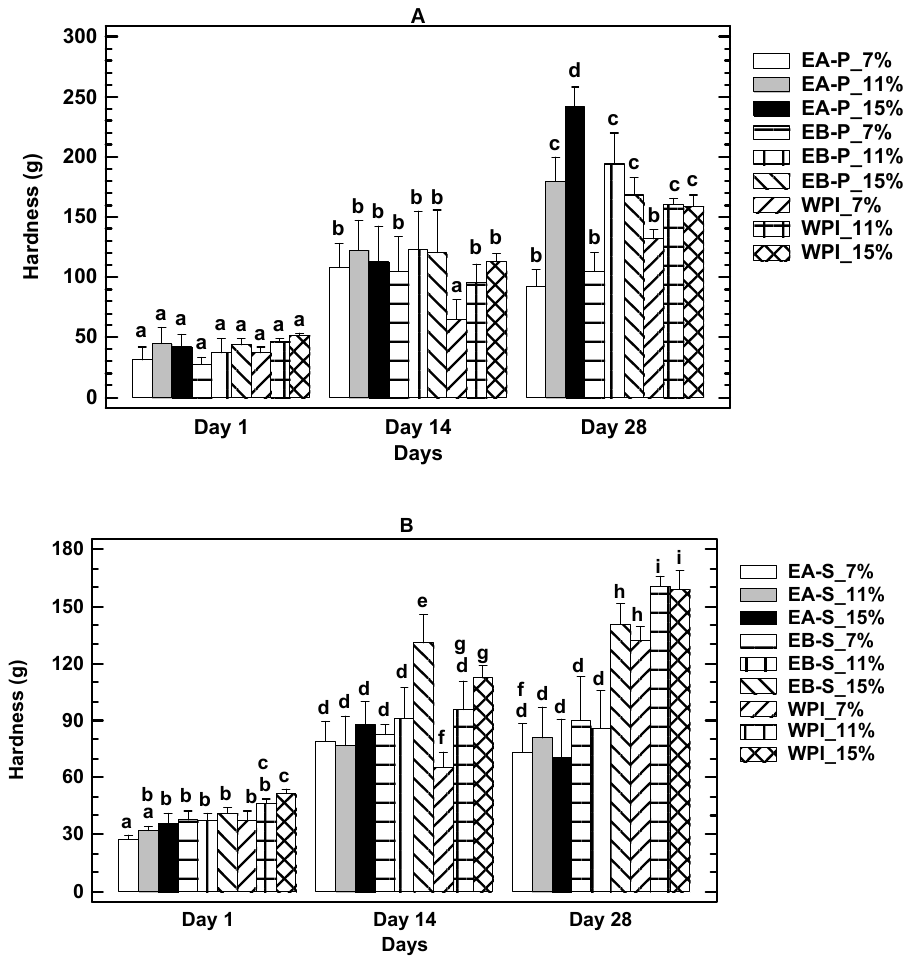
Figure 2. Firmness after 1, 14 and 28 days of storage ( A ) Soluble fraction, ( B ) Pellet. EA = Acid Extraction, EB = Alkaline Extraction, WPI = Whey Protein Isolate. Same letter means no significantly differences by figure. (Tables S1 and S2 Supplementary Materials).